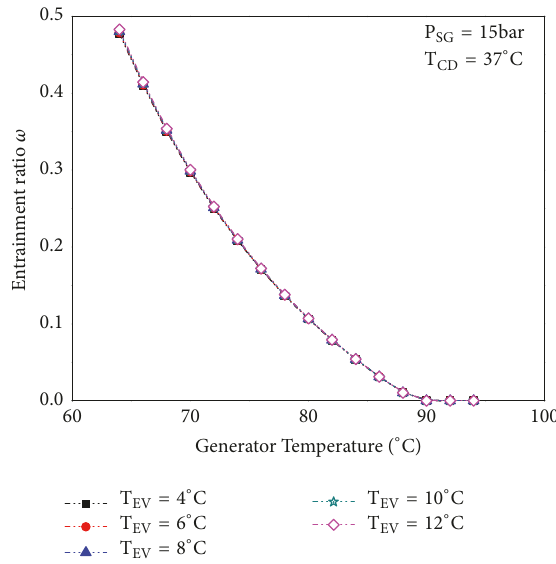
Figure 14: 𝜔 vs . 𝑇 𝐺 for various evaporator temperature 𝑇 𝐸𝑉